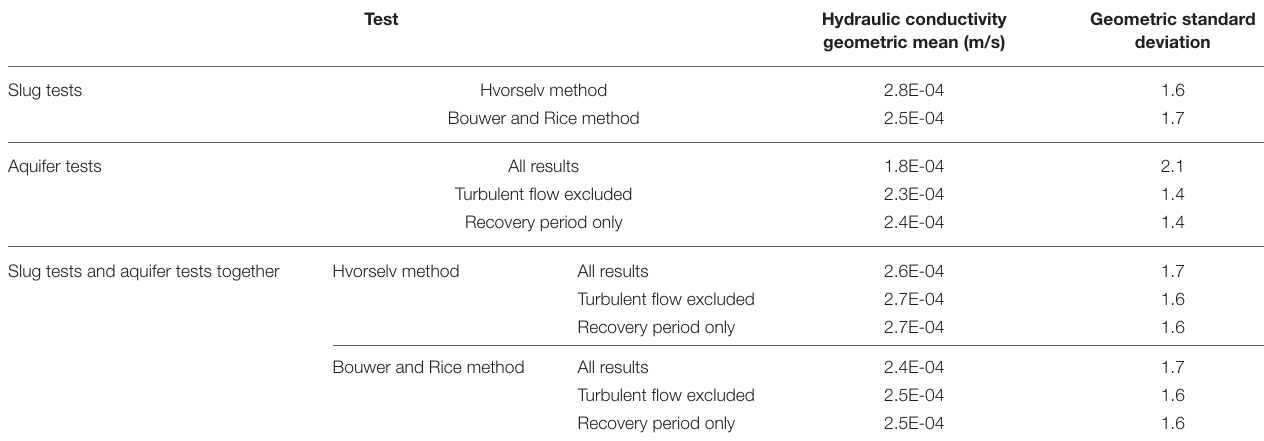
TABLE 3 | Hydraulic conductivity results.